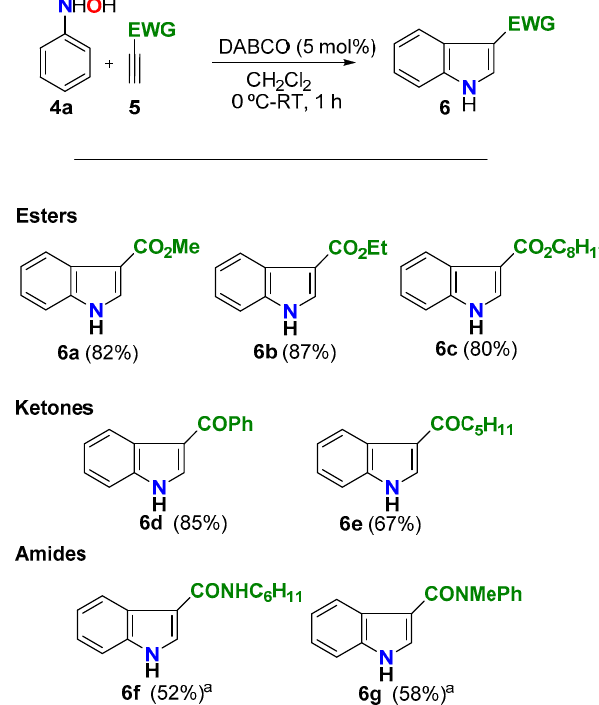
Scheme 4. Alkyne scope of the protocol. Reaction conditions: N -phenylhydroxylamine ( 4a )